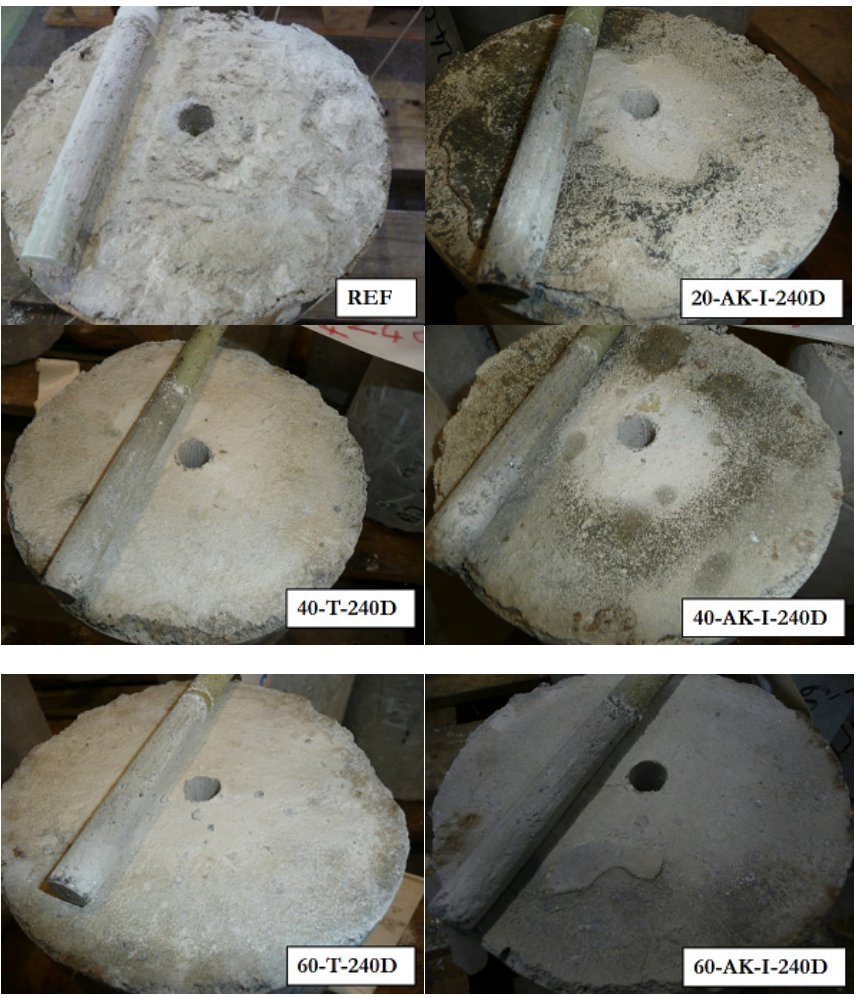
Figure 19. Typical failure modes observed after pull-out tests on reference and aged specimens. Bond strength values determined on reference and aged pull-out specimens are re- ported in Table 10 and summarized in Figure